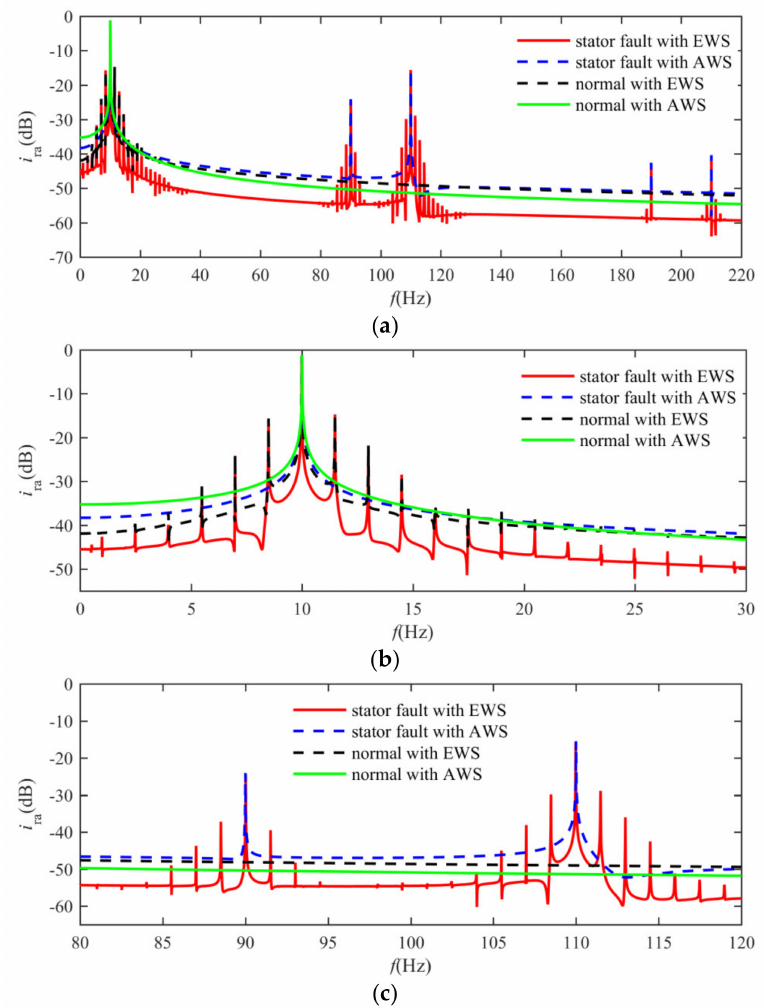
Figure 13. Rotor current comparison under the stator winding asymmetry: ( a ) PSD of the rotor current from 0 to 220 Hz; ( b ) PSD of the rotor current from 0 to 30 Hz; ( c ) PSD of the rotor current from 80 to 120